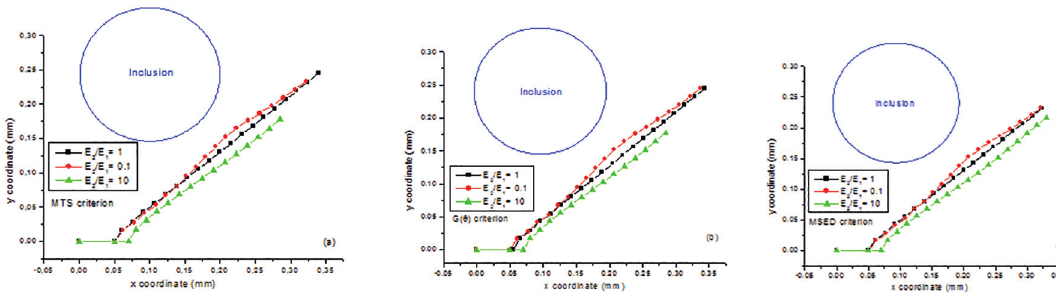
Figure 17: Inclusion effect on the crack propagation path predicted by: a) MTS criterion, b) G(θ) criterion, b) MSED criterion 11,36